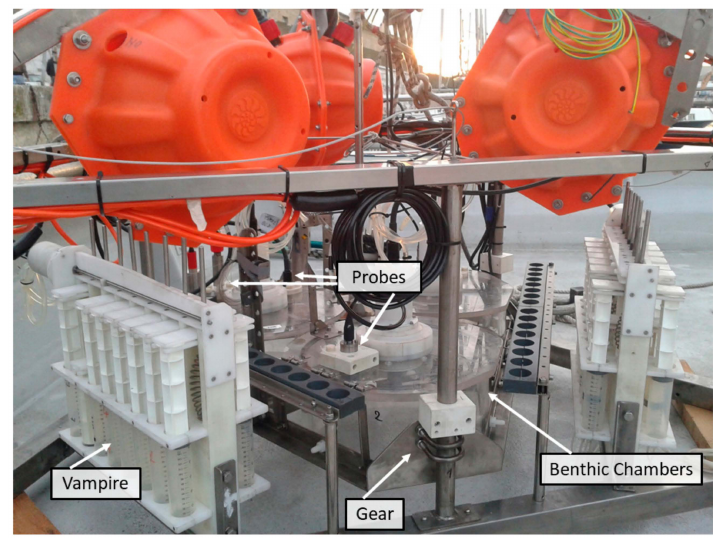
Figure 8. Amerigo Lander: The three benthic chambers, the two water sampling devices, the three probes in a chamber, and the chassis on which the chambers are mounted.